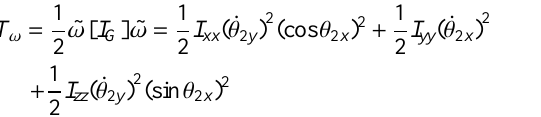
Figure 4: WBC plan for gantry crane with planar-moving trolley